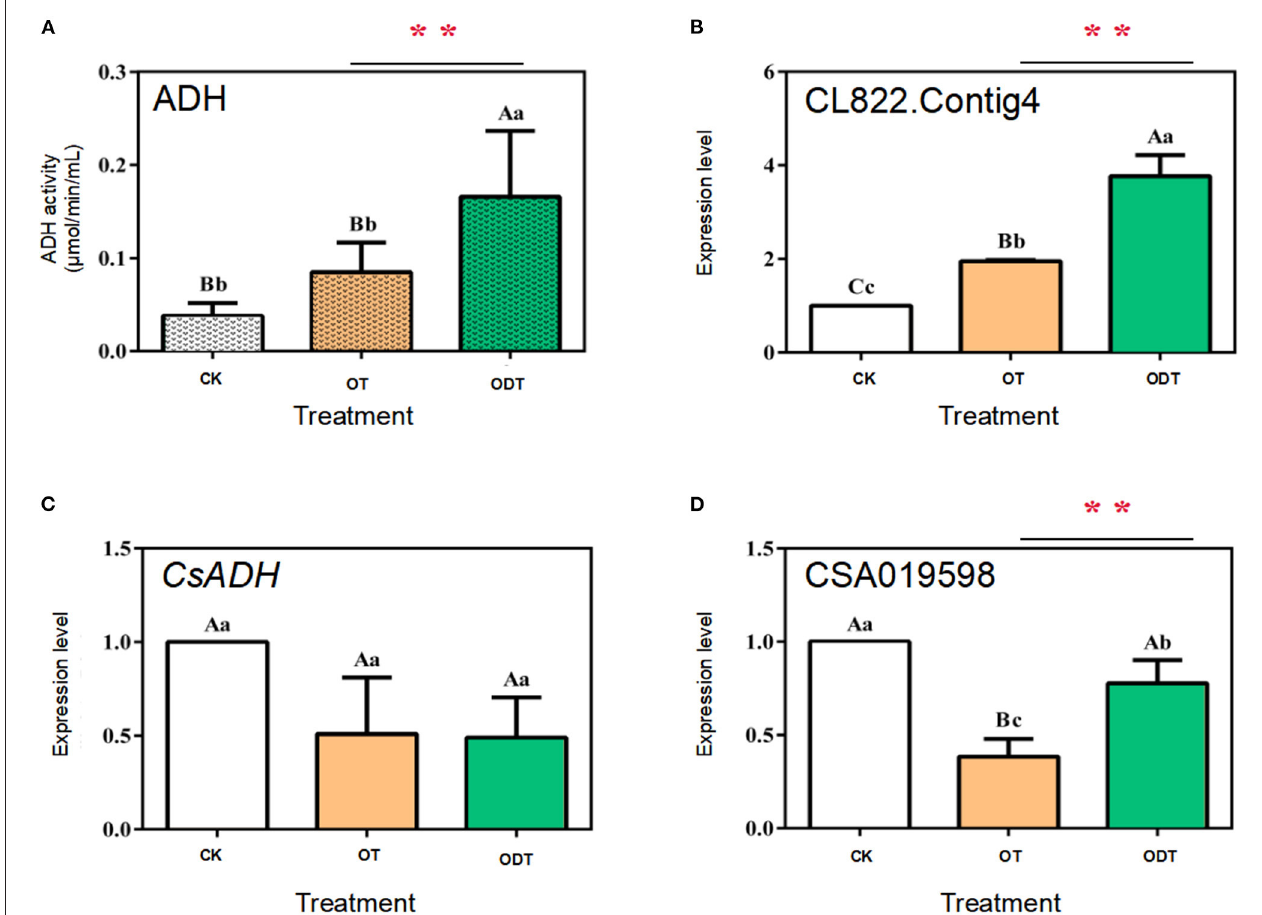
FIGURE 5 | ADH enzyme activity and relative expression levels of three CsADH genes under normoxic and hypoxic conditions during the turnover process of oolong tea. (A) Enzyme activity of ADH (EC 1.1.1.1); (B–D) expression levels of (B) CSA019598, (C) CSA019598 of CsADH (GenBank accession no. HM440157.1), and (D) CL822.Contig4. Data are expressed as means ± standard errors of the mean of six independent experiments. Different uppercase letters ( P < 0.01) and lowercase letters ( P < 0.05) indicate significant differences among different treatments from Tukey’s test. CK (control group) represents fresh tea leaves without any treatment. ODT (oxygen-deficient leaves) represents fresh tea leaves turned over under hypoxic conditions. OT (normal leaves) represents fresh tea leaves turned over under normoxic conditions. Two asterisks denote a statistically significant difference (** P < 0.01) in relative amount between ODT and OT during the postharvest processing of oolong